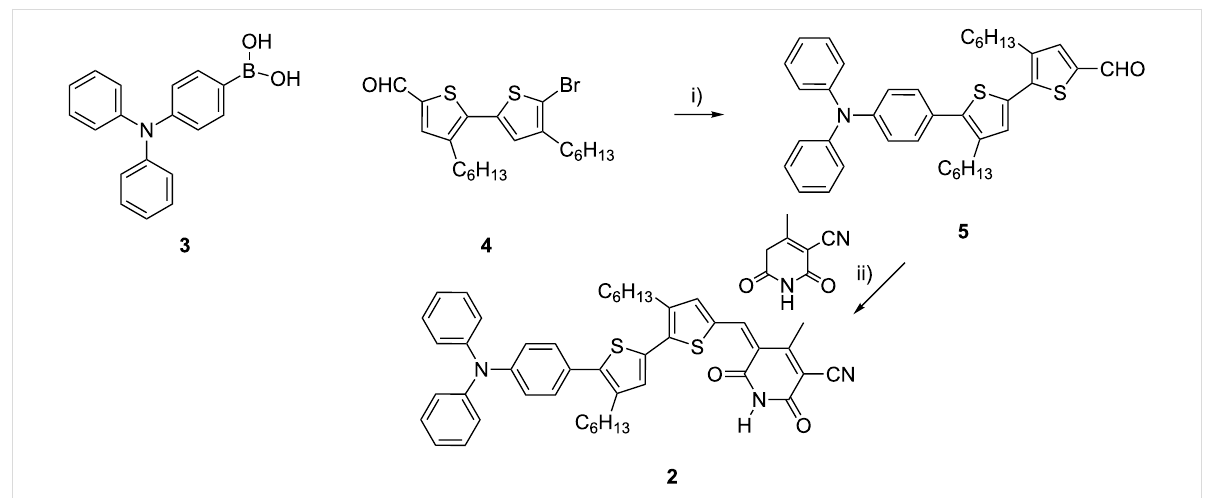
Scheme 1: Synthesis of the cyanopyridone 2 , reagents and conditions: (i) Pd(PPh 3 ) 4 , Cs 2 CO 3 , toluene, reflux, 16 h, 84%; (ii) EtOH, reflux, 2 h,